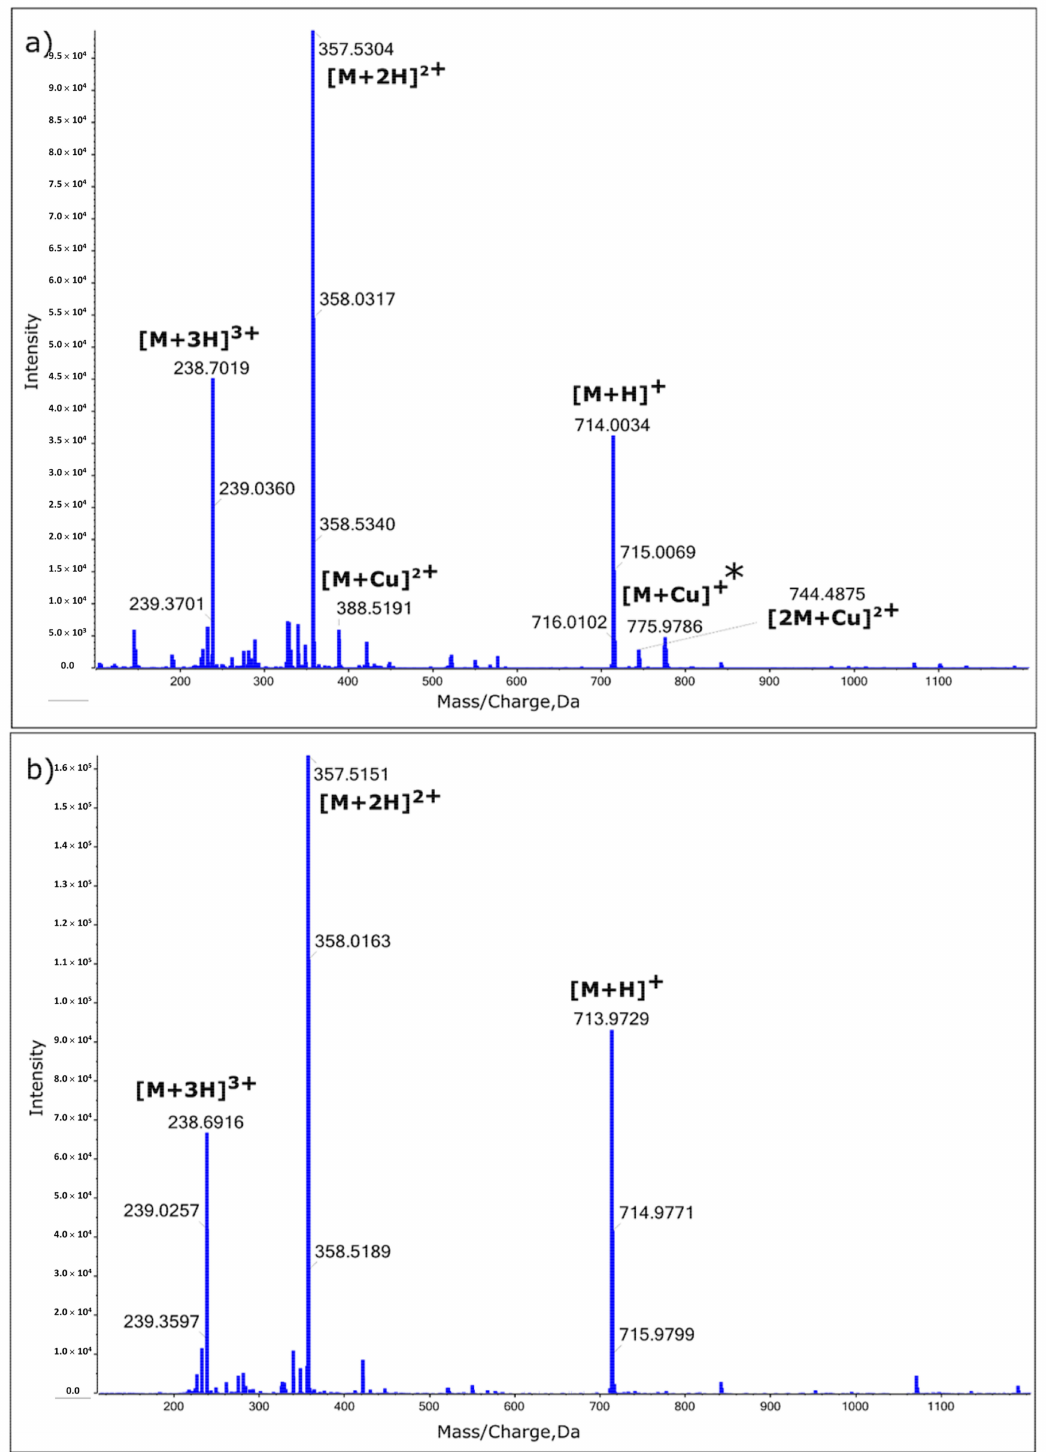
Figure 8. The MS spectra of the 2 mM solutions of EHYHQ in the presence of 10 mM of Cu 2 + ions ( a ) and in the absence of Cu 2 + ions ( b ). * Cu(II) can be reduced to Cu(I) in positive-ion mode electrospray mass spectrometry